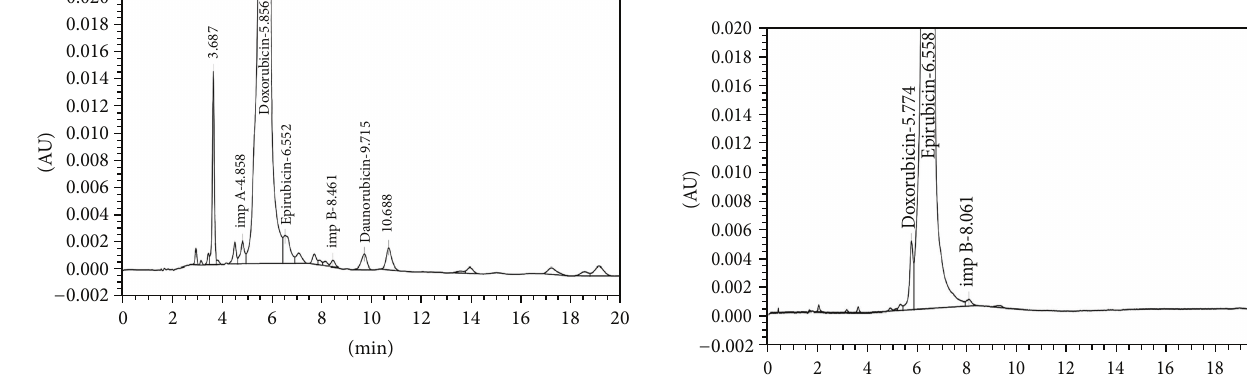
Figure 11: HPLC profile of irradiated doxorubicin (25 kGy).